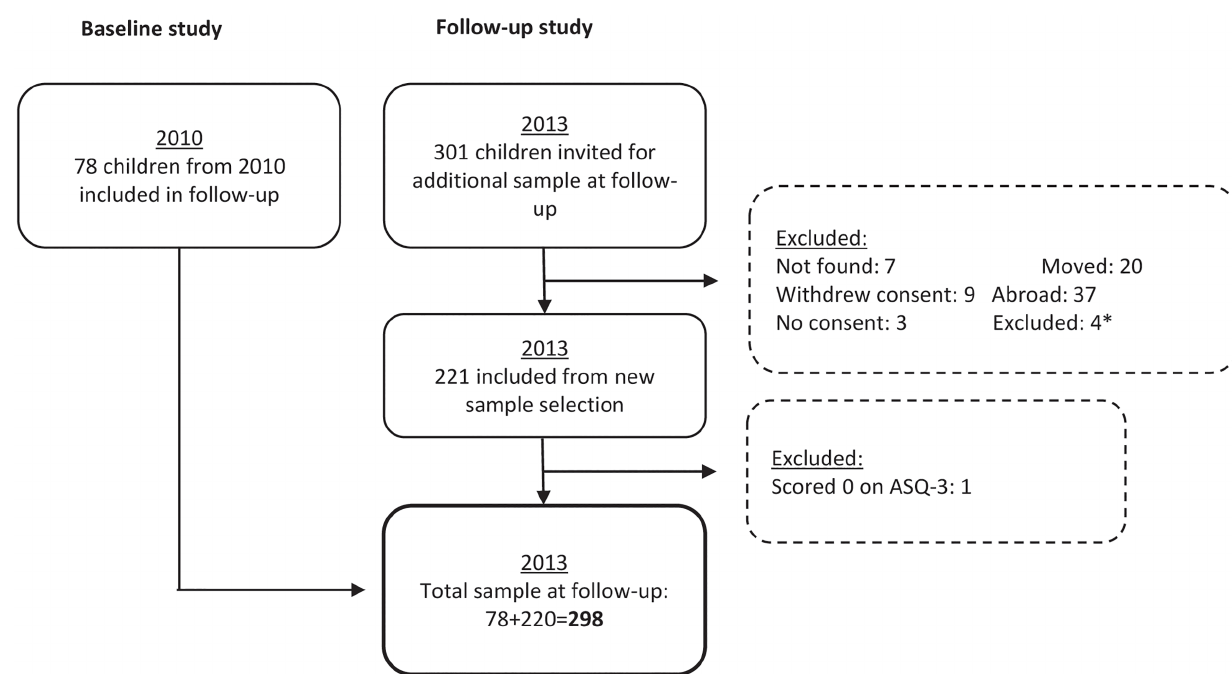
Fig 1. Flowchart for selection of Saharawi children from 2010baseline study and 2013follow-up study. * low age, high age, deaf, and mute.